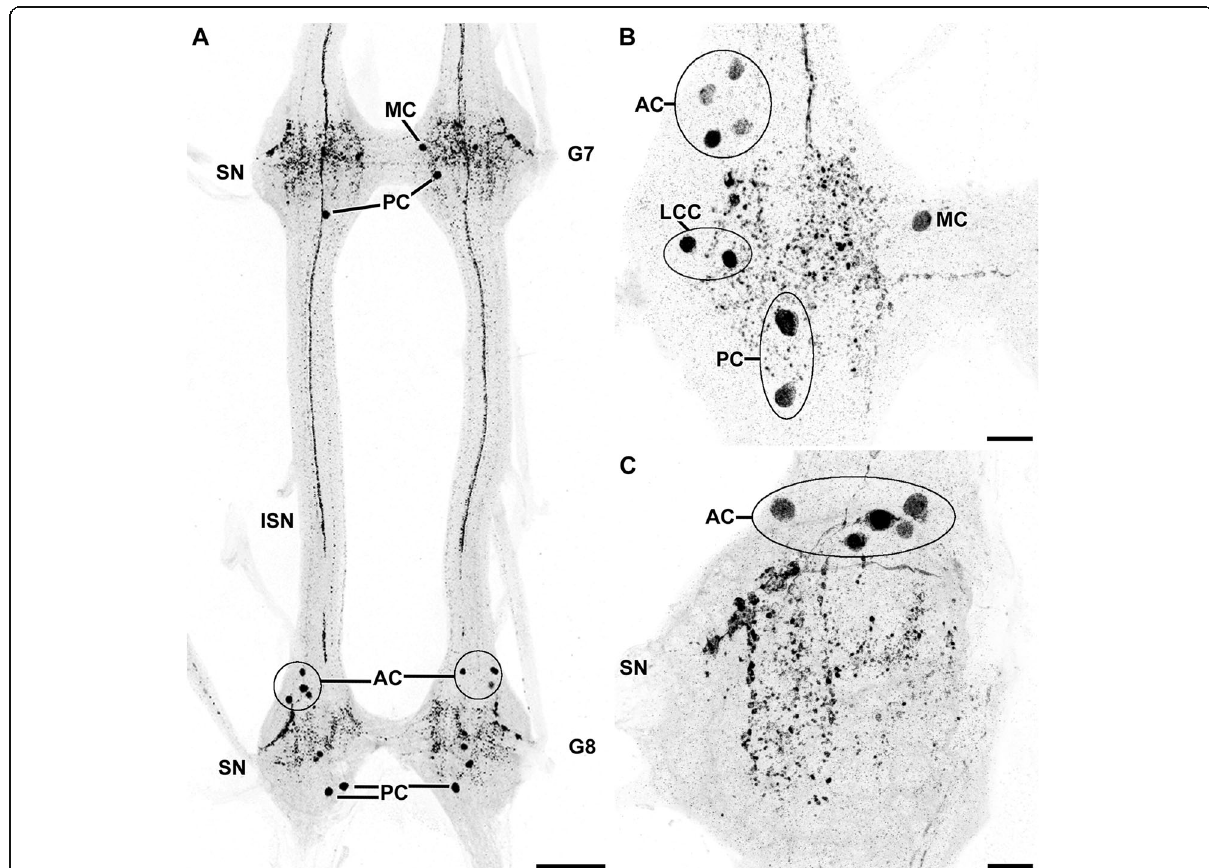
Fig. 4 Histaminergic neurons in the ventral nerve cord of Xibalbanus tulumensis . Maximum projections of cLSM stacks (ventral view, anterior to the top). a Overview of the ganglia 7 and 8 (G7 – 8), showing the typical rope-ladder like arrangement and the variability concerning number and distribution of the histaminergic cell bodies. b Close-up of a representative hemiganglion, depicting anterior (AC), laterocentral (LCC), medial (MC) and posterior cell bodies (PC). c The cluster of anterior AC contained up to five immunoreactive neurons. Abbreviations: AC: anterior cell bodies; G7 – 8: ganglion 7 – 8; ISN: intersegmental nerve; LCC: laterocentral cell bodies; MC: medial cell bodies; PC: posterior cell bodies; SN: segmental nerve. Scale bars: a: 100 μ m; b, c: 25 μ